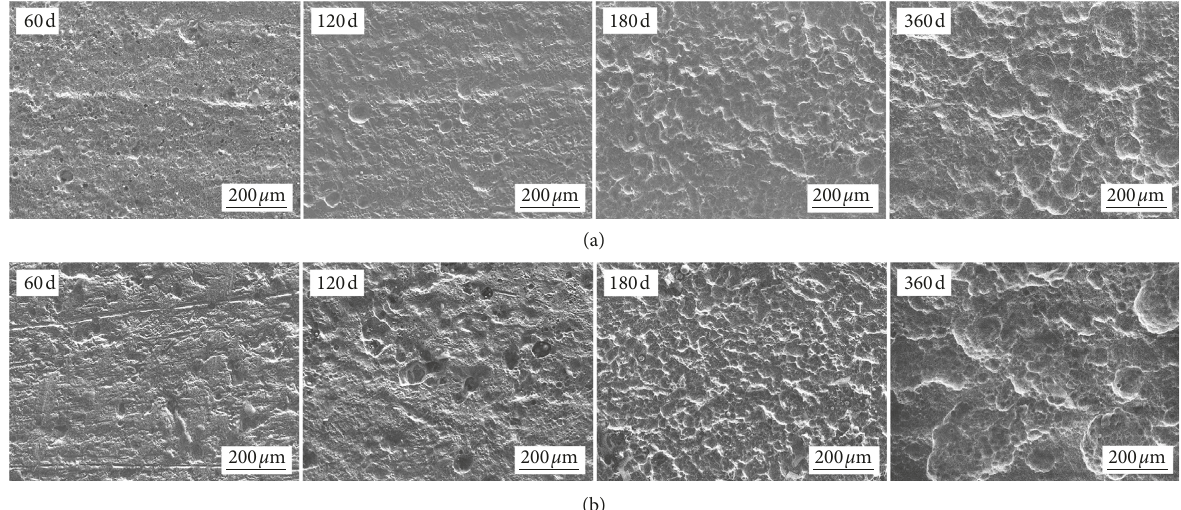
Figure 3: Evolution of corrosion morphology on weld joint’s surface. (a) Weld joint processed by VSR. (b) Weld joint unprocessed by VSR.